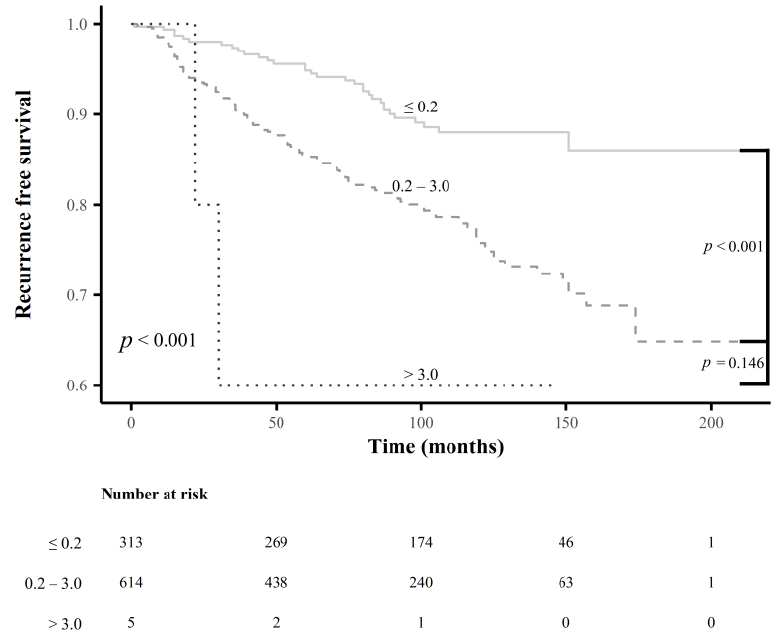
Figure 4. Comparison of the recurrence-free survival rates between the subgroups according to the current cutoff values for the maximal diameter of metastatic lymph node foci.